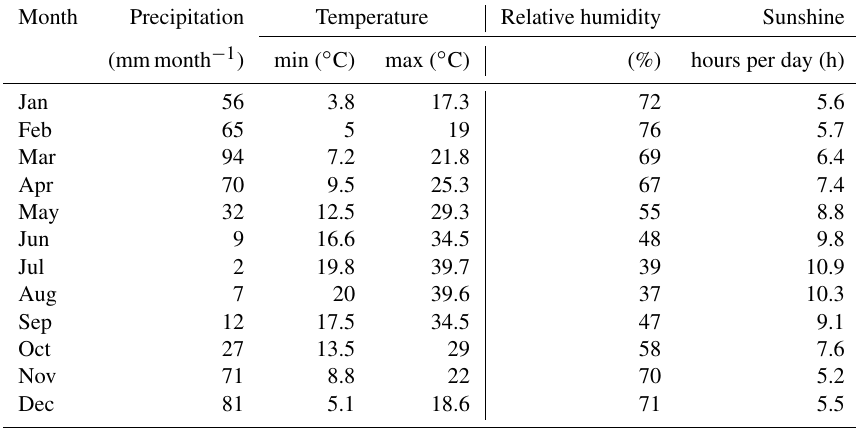
Table 3. Climate information in